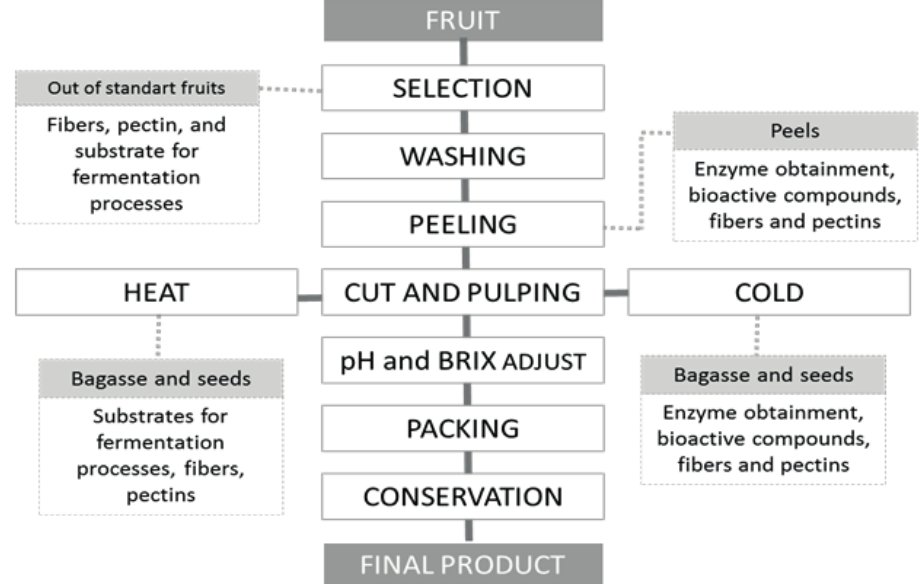
Figure 1 - Wastes generated during fruit processing and possible biotechnological